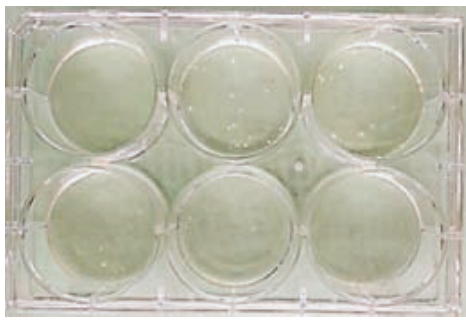
Fig. 6. Network of budding yeast cells on CVS assay X400, crystal violet stain